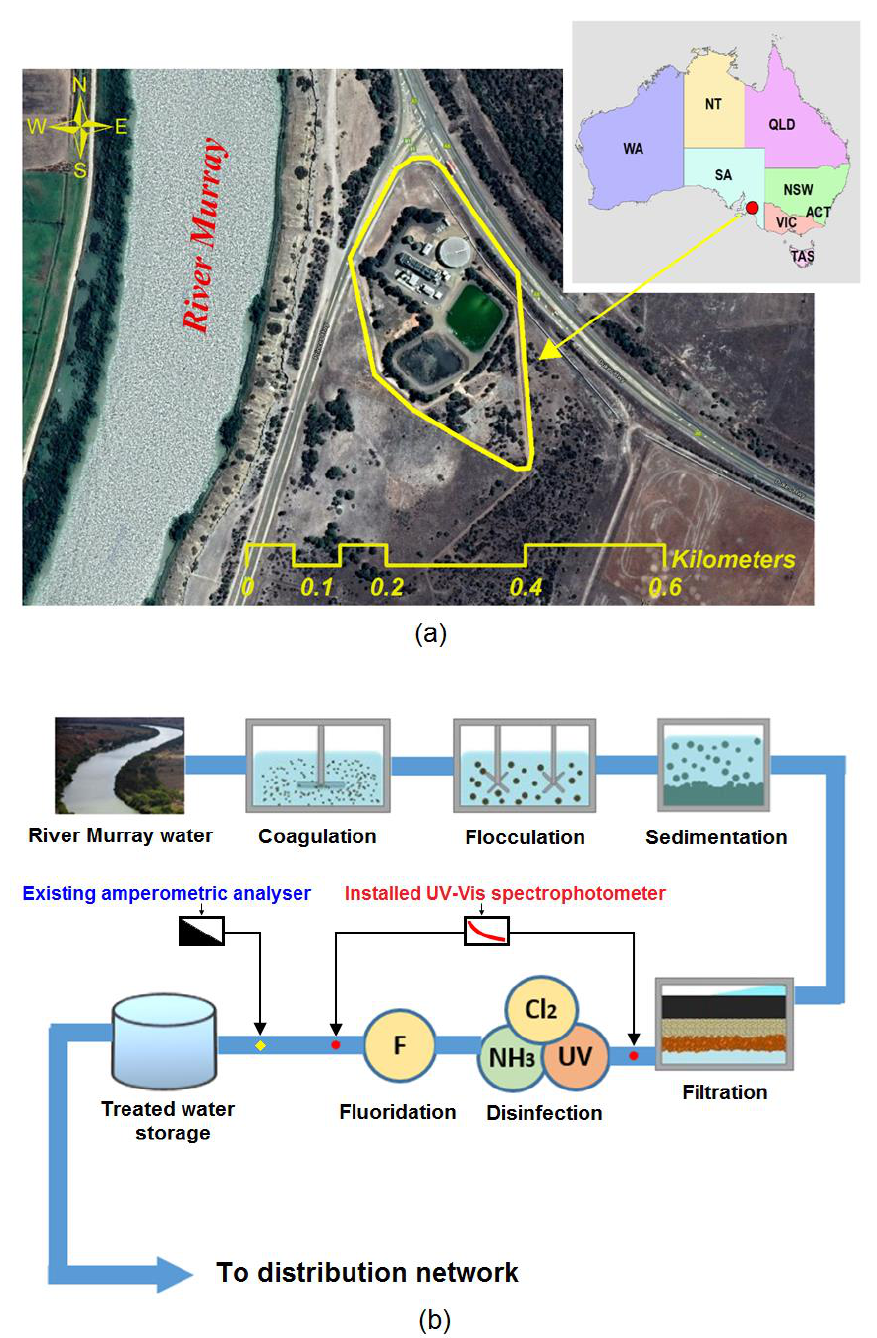
Figure 2. ( a ) Aerial view of Tailem Bend water treatment plant (WTP) and ( b ) Schematic of the water treatment process at Tailem Bend WTP and the installation location of the UV-Vis spectrophotometer (the spectrophotometer is fed water from two different sample points marked by the red dot in the figure).